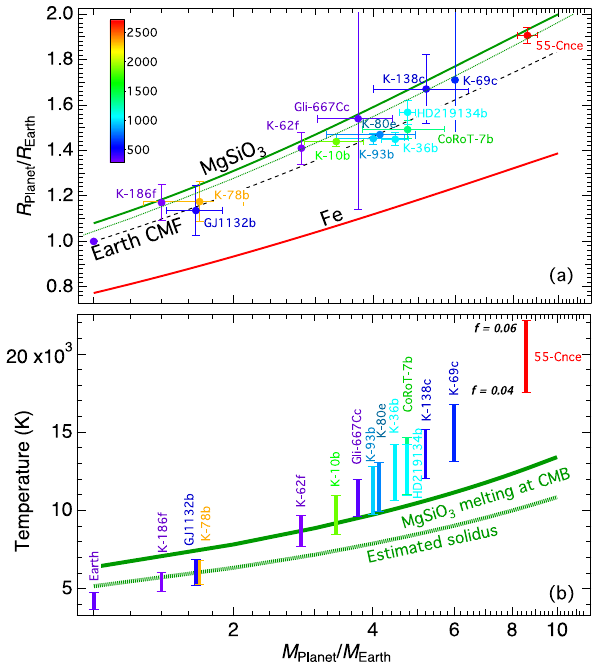
Fig. 3 Calculated radius ratios and temperatures at the core-mantle boundary after accretion as a function of mass ratios. a MgSiO 3 mantle is represented by a green solid curve, pure Fe core by red solid curve 30 , and MgSiO 3 – Fe planet with Earth CMF by black dashed curve. The calculated curve for a FeO-free Earth-like mantle 35 with Mg/Si = 1.07 (green dotted curve) is shown for comparison. Observations for selected super-Earths (www.exoplanet.eu) are shown with a color scale indicating the estimated planetary equilibrium temperatures in Kelvin. Data without horizontal errors indicate that the mass is not well constrained. b Colored symbols represent the calculated CMB temperatures of the selected super-Earths, compared with the MgSiO 3 melting curve and its estimated solidus temperatures calculated by T solidus = T melting /(1 − ln0.79) 37 . The lower bounds were calculated using the Earth-like f = 0.04 whereas the upper bounds using f =